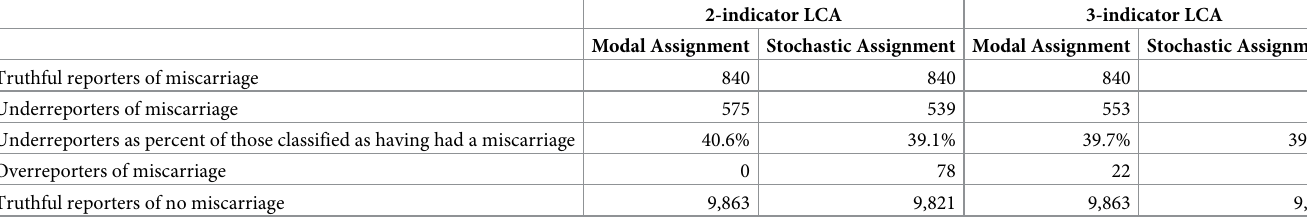
Table 5. Miscarriages reporting behaviors